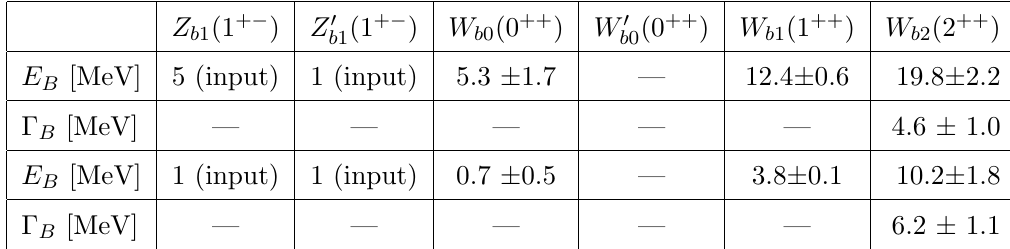
Table 1 . The binding energies and the widths of the spin partners for the two sets of the Z b and Z 0 binding energies used as input parameters. The uncertainty in the results is due to the variation b of the cuto(cid:11) in the Lippmann-Schwinger equations from 800 to 1500